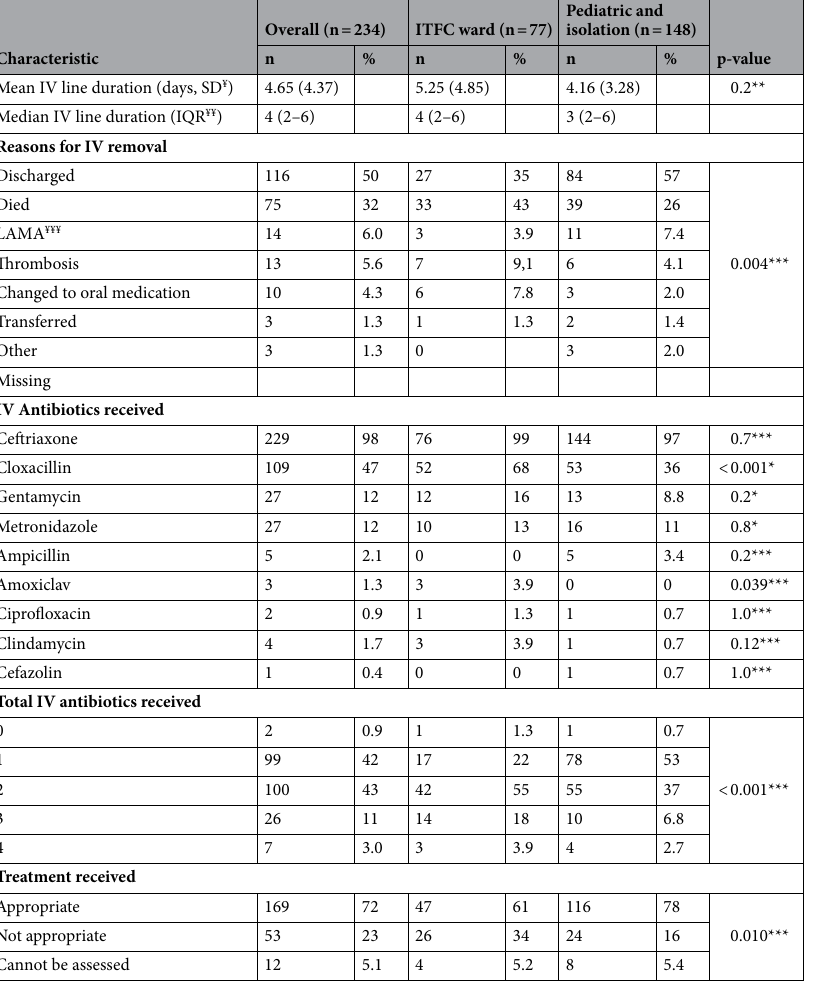
Table 3. Clinical course and treatment received with IV antibiotics for pediatric patients admitted with severe sepsis in AGH, November 2018-August 2020. ¥ Standard Deviation, ¥¥ Interquartile range, ¥¥¥ Left